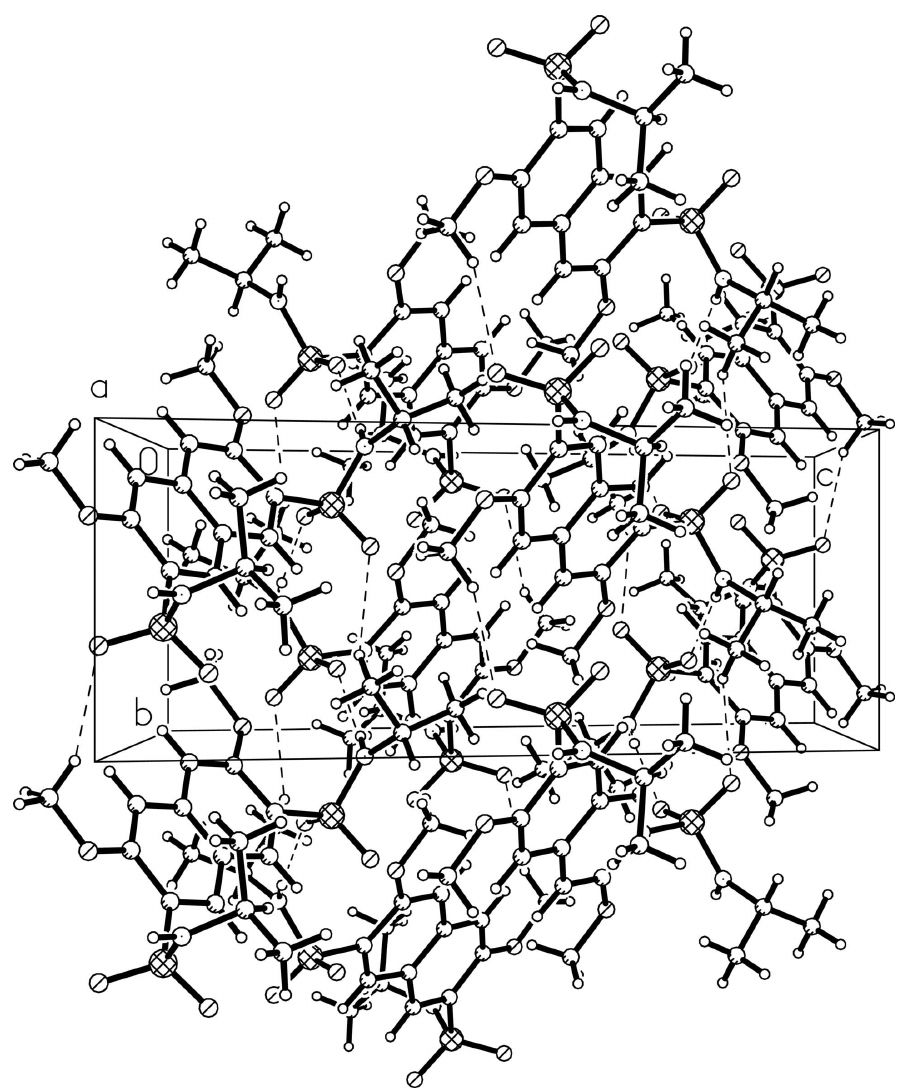
The packing of (I), viewed down the a axis, showing one layer of molecules connected by N—H···O hydrogen bonds (dashed